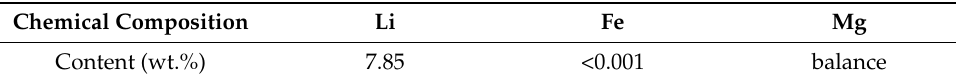
Table 1. Chemical composition of Mg-8%Li alloy. Chemical